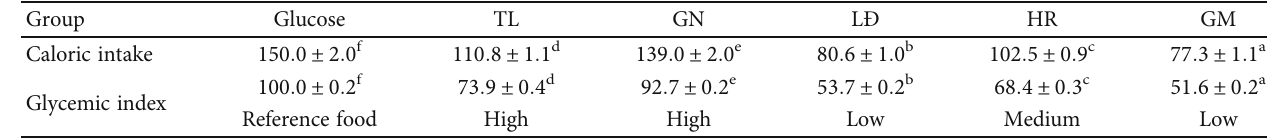
Table 3: Caloric intake and glycemic index of tested groups 1 .